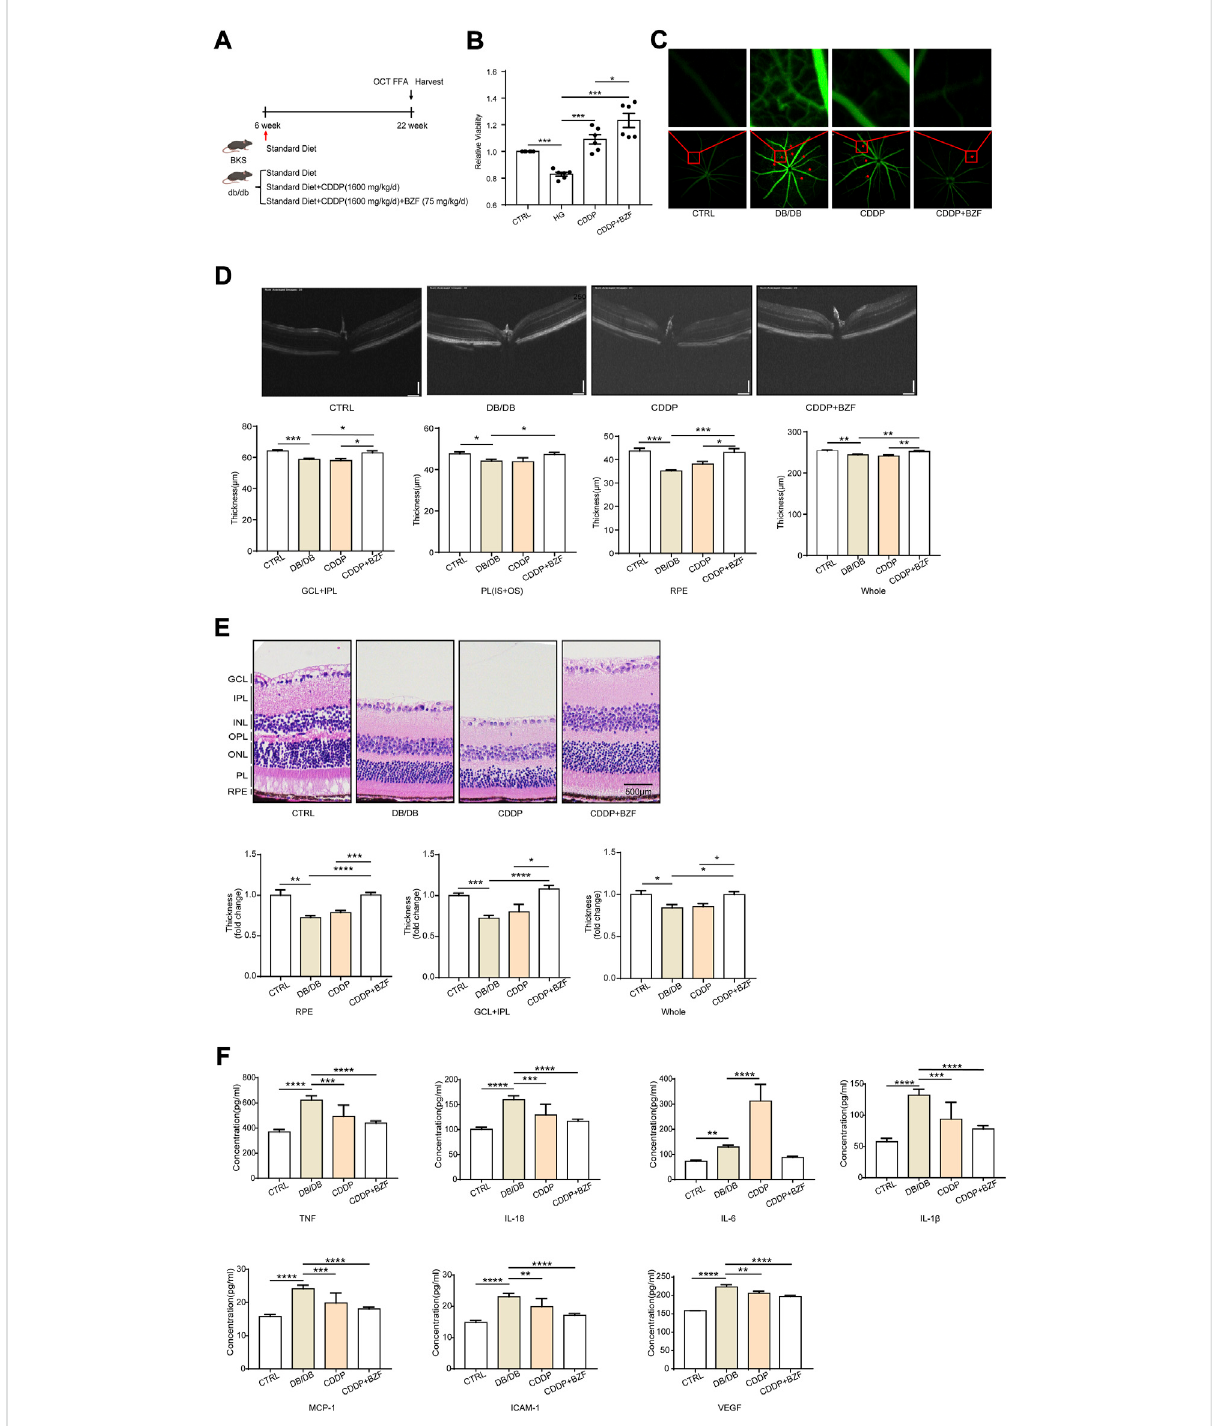
FIGURE 2 Effects of coadministration of CDDP and BZF on the disease phenotype of DR in db/db mice. (A) Graphical experimental protocol for the mice, (B) CCK-8cytotoxicitytest, (C) FFA fl uorescentimagesofretinalbloodvessels, (D) OCTimagesandstatisticalchartsofthefundusoculiofmice, (E) H&E-stained sections of the RPE layer in mice (20×), and (F) ELISA assays of TNF- α , IL-6, IL-18, IL-1 β , MCP-1, ICAM-1 and VEGF in mouse plasma ( n ≥ 5ineachgroup).Unpaired t -test.* p < 0.05, ** p < 0.01,*** p < 0.001,**** p < 0.0001.CTRL: control;HG:high-glucose;GCL+IPL:ganglion cell layer and inner plexiform layer; PL(IS + OS): photoreceptor